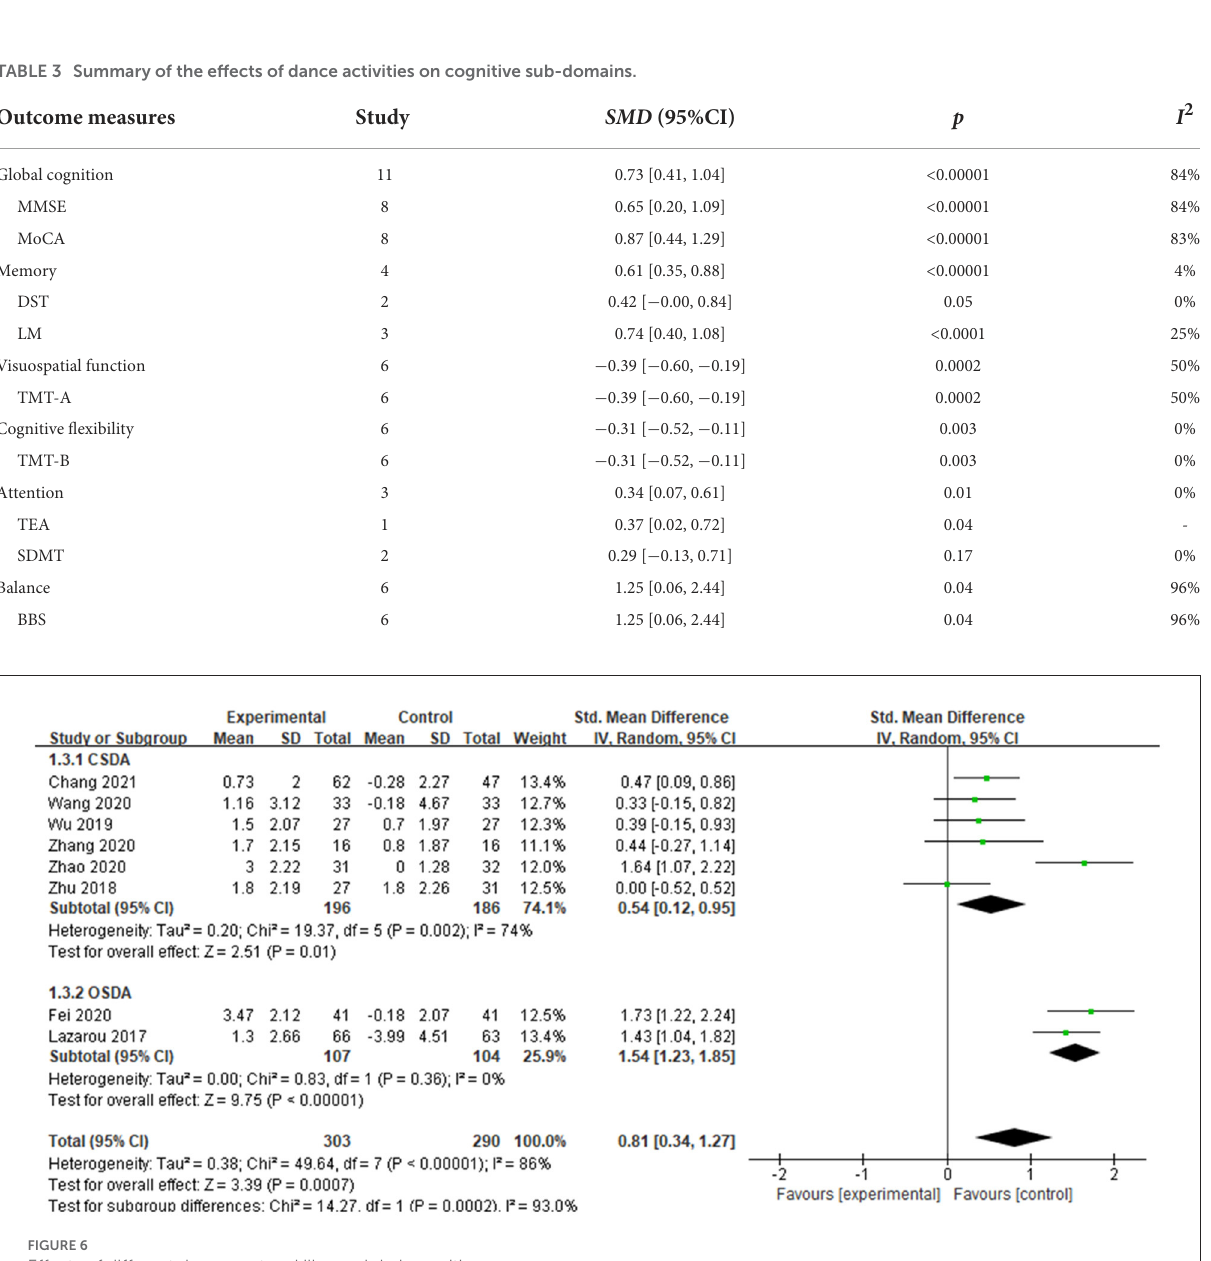
FIGURE6 Effects of different dance motor skills on global